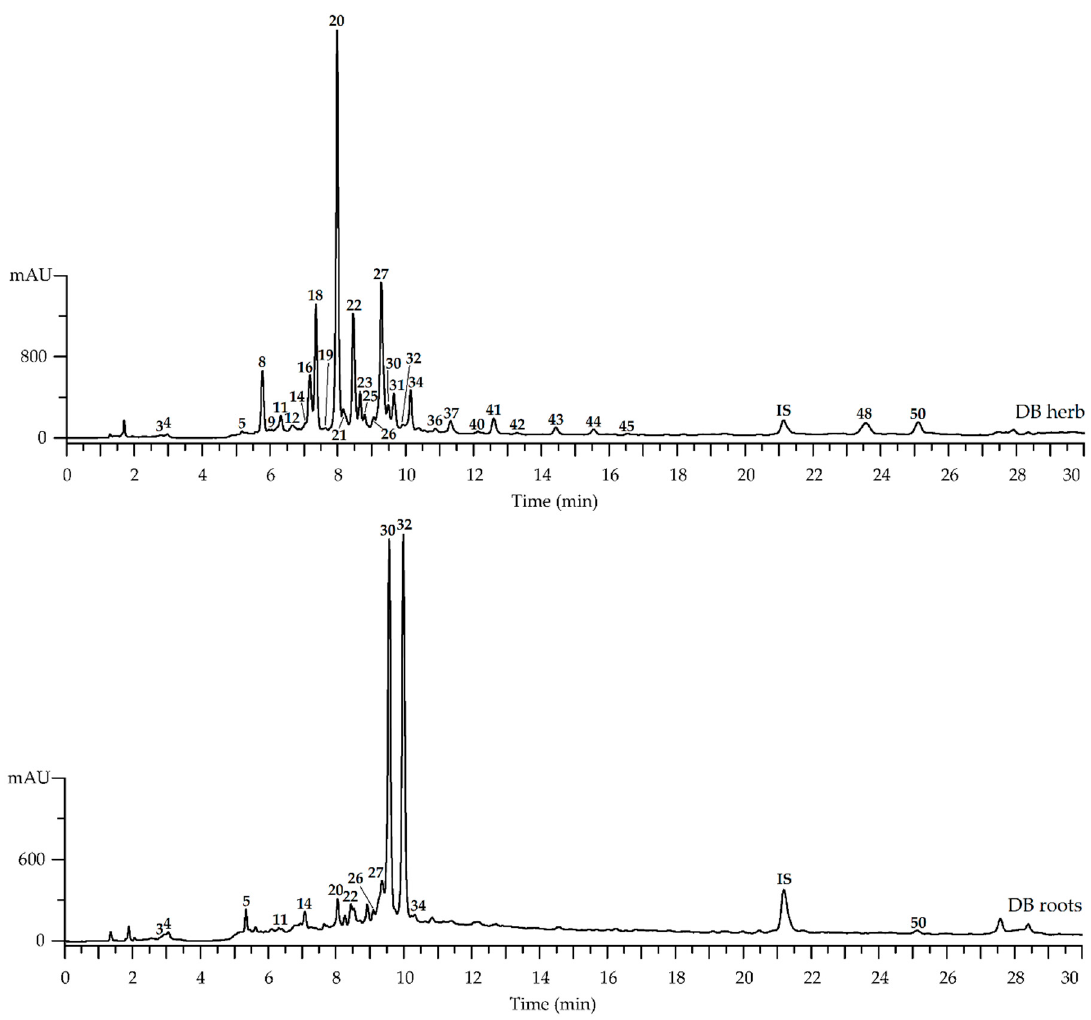
Figure 3. High-performance liquid chromatography with photodiode array detection (HPLC-PDA) chromatograms (270 nm) of herb and root extracts of Dracocephalum botryoides (DB). Compounds are numbered as listed in Table 1. IS—3 ′ ,4 ′ -di- O -acetyl-cis-khellactone (5 μ g/mL).